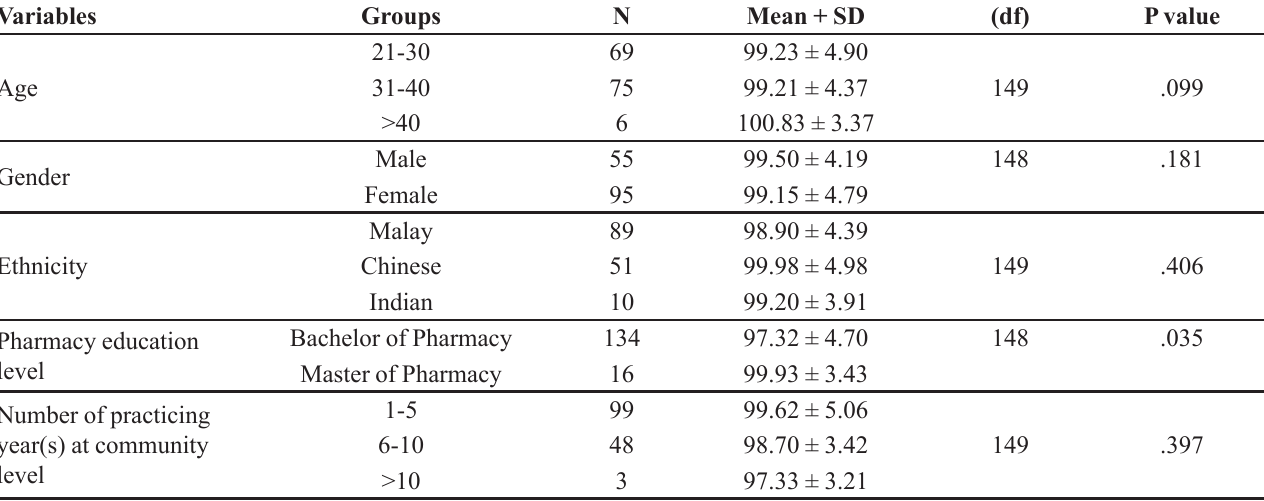
TABLE III - Distribution of perceived practice of asthma according to socio-demographic variables Variables